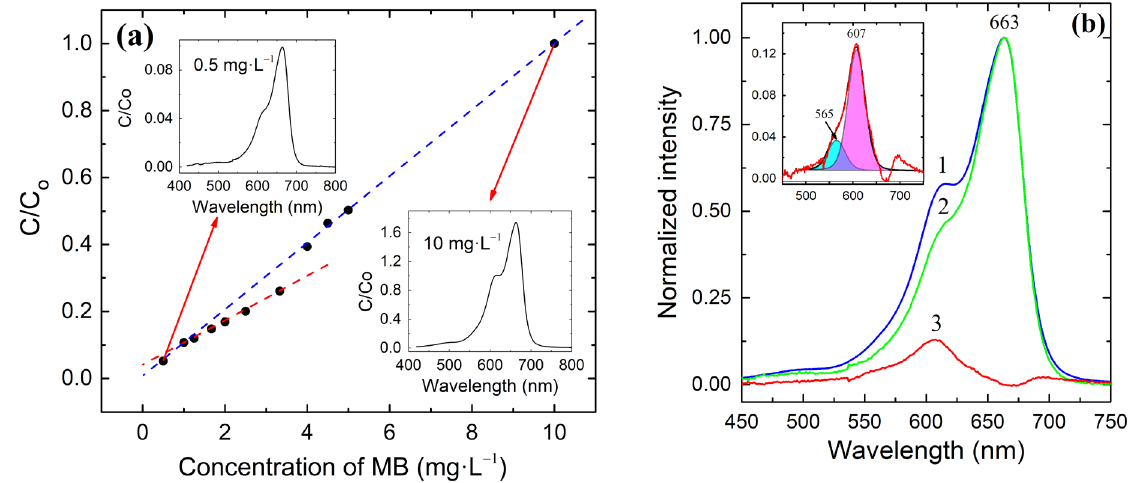
Figure 1. Concentration dependence of the normalized absorbance of MB aqueous solutions in a concentration range of 0.5 to 10 mg·L −1 (from 1.56 × 10 −6 to 3.13 × 10 −5 mol·L −1 ) at 25 °C ( a ). The insets in ( a ) show absorbance spectra at the lowest and highest measured concentrations. Normalized absorbance of MB solution ( b ): 10 mg·L −1 (curve 1) and 0.5 mg·L −1 (curve 2). Curve 3 represents the difference spectrum obtained by subtracting curve 2 from curve 1. Inset in ( b ) shows the deconvolution of difference spectrum 3.